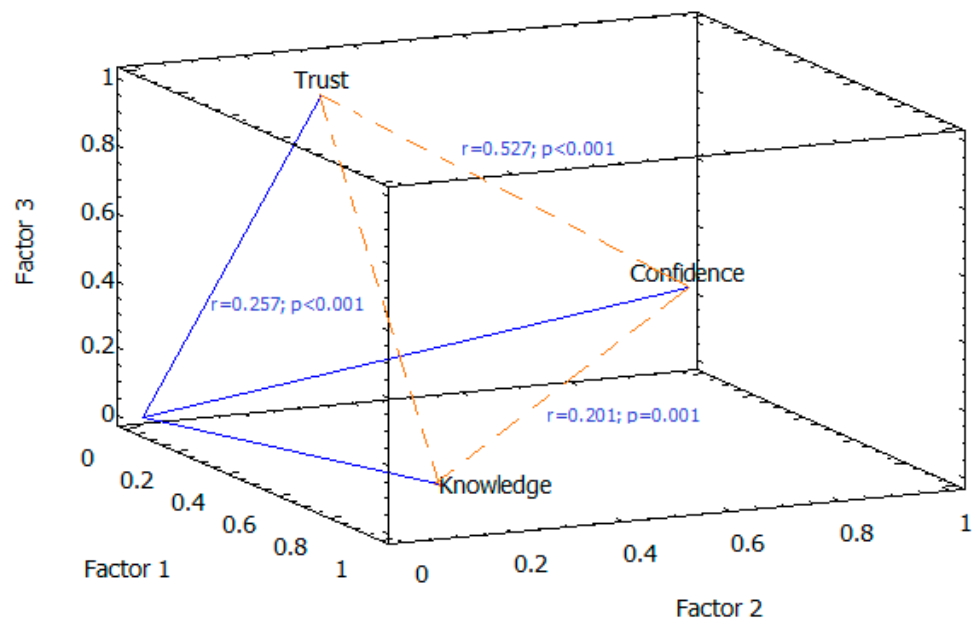
Figure 2. Factor loading components and correlation of variables. The strongest correlation was observed between confidence and trust with factor 2.